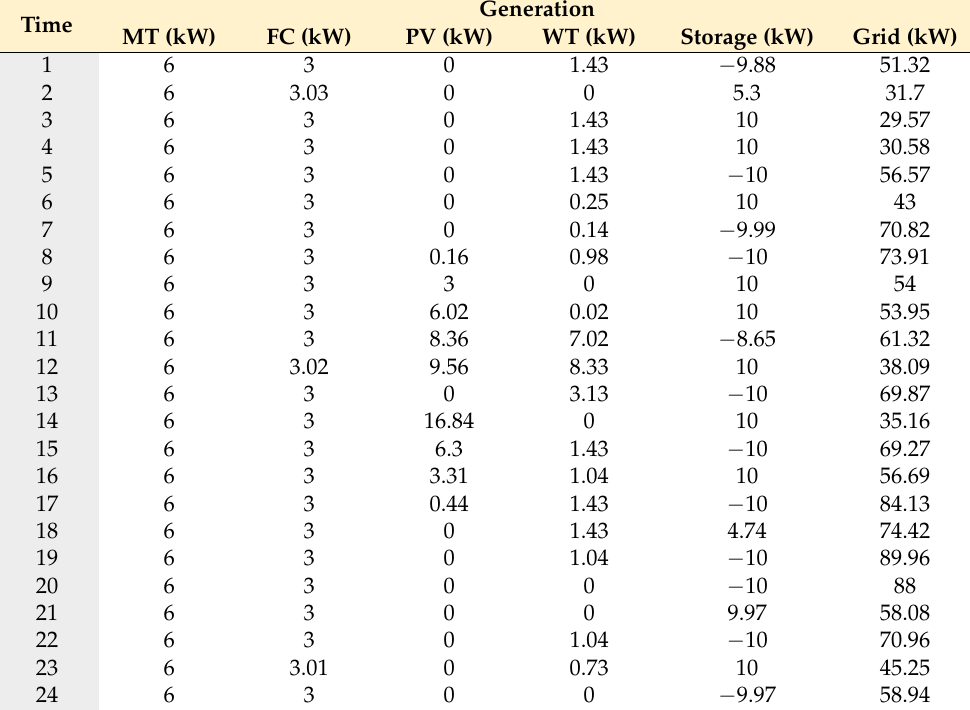
Figure 3. Convergence diagram of emission in different methods without considering the limitations of upstream power exchange. Table 6. Distributing power to reduce pollution without considering the limitation of upstream exchange.